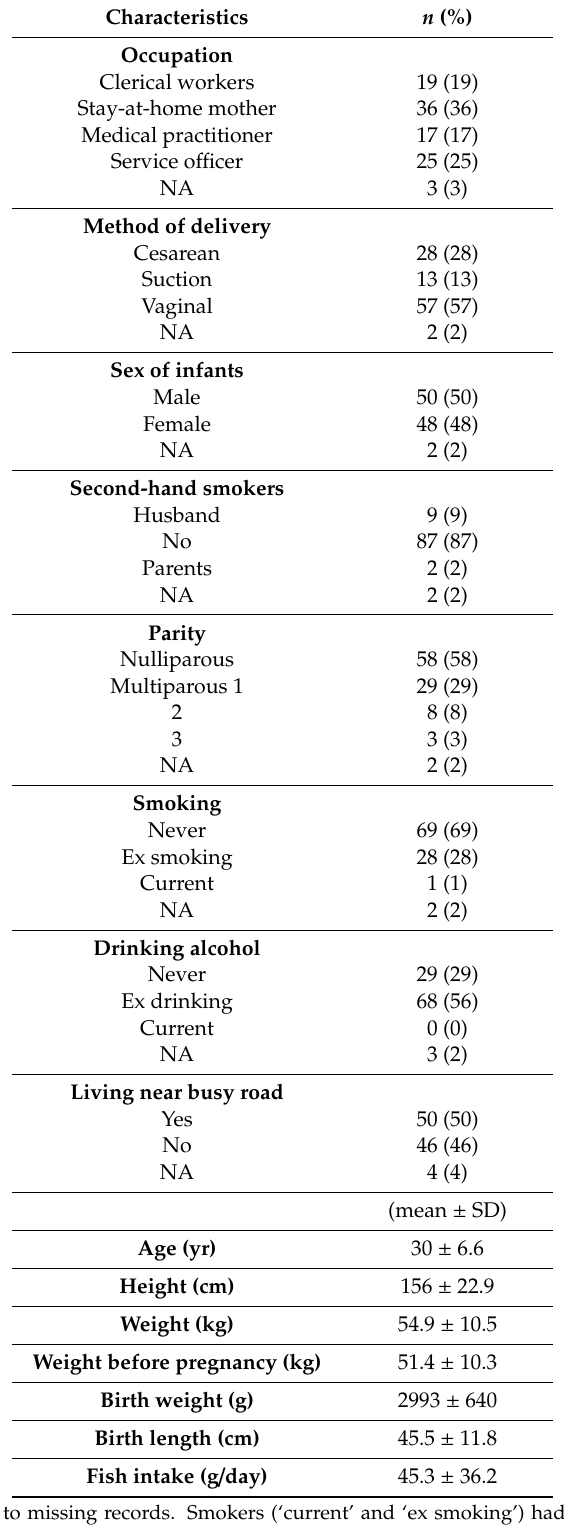
Table 1. Baseline characteristic of respondents at sampling of breast